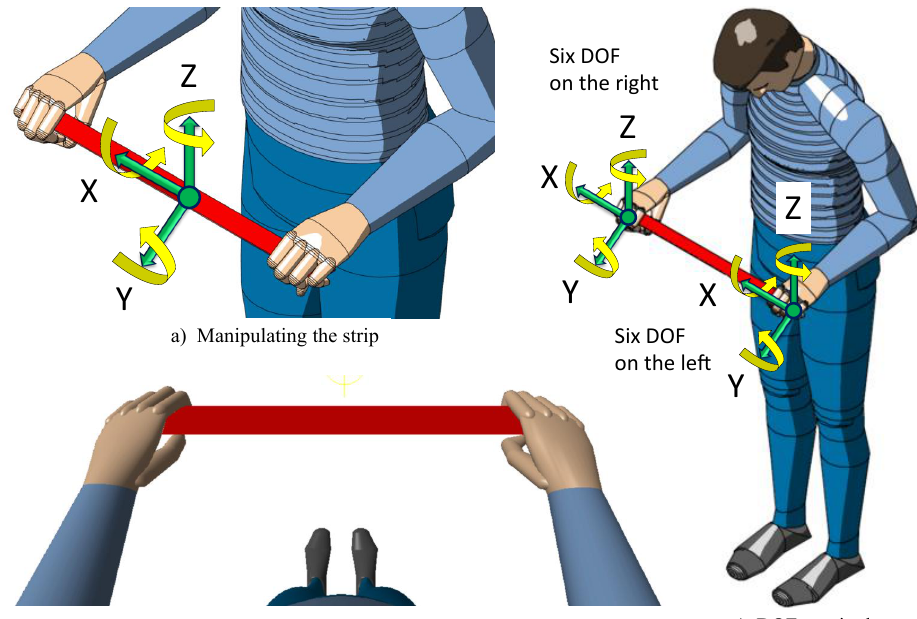
Figure 1. User’s intent for manipulating the haptic